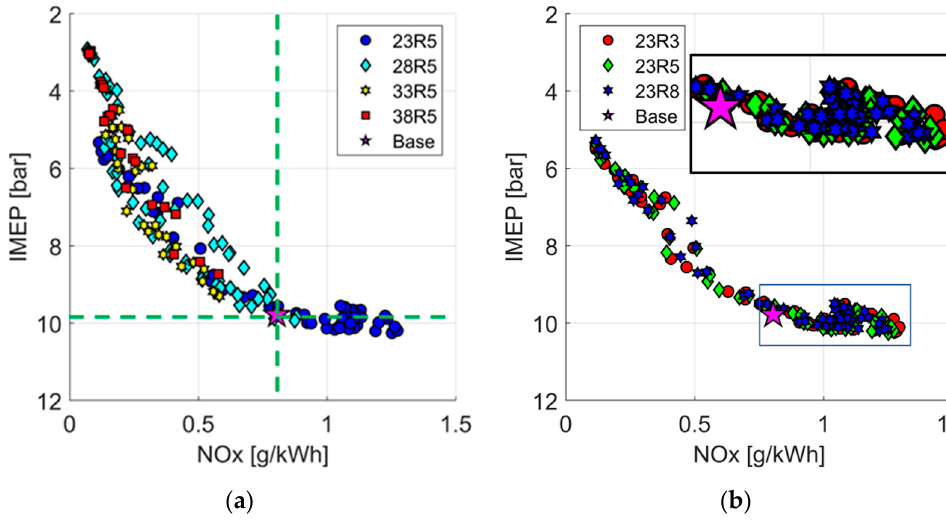
Figure 6. ( a ) FL with all bowls; ( b ) FL with a focus on R23.